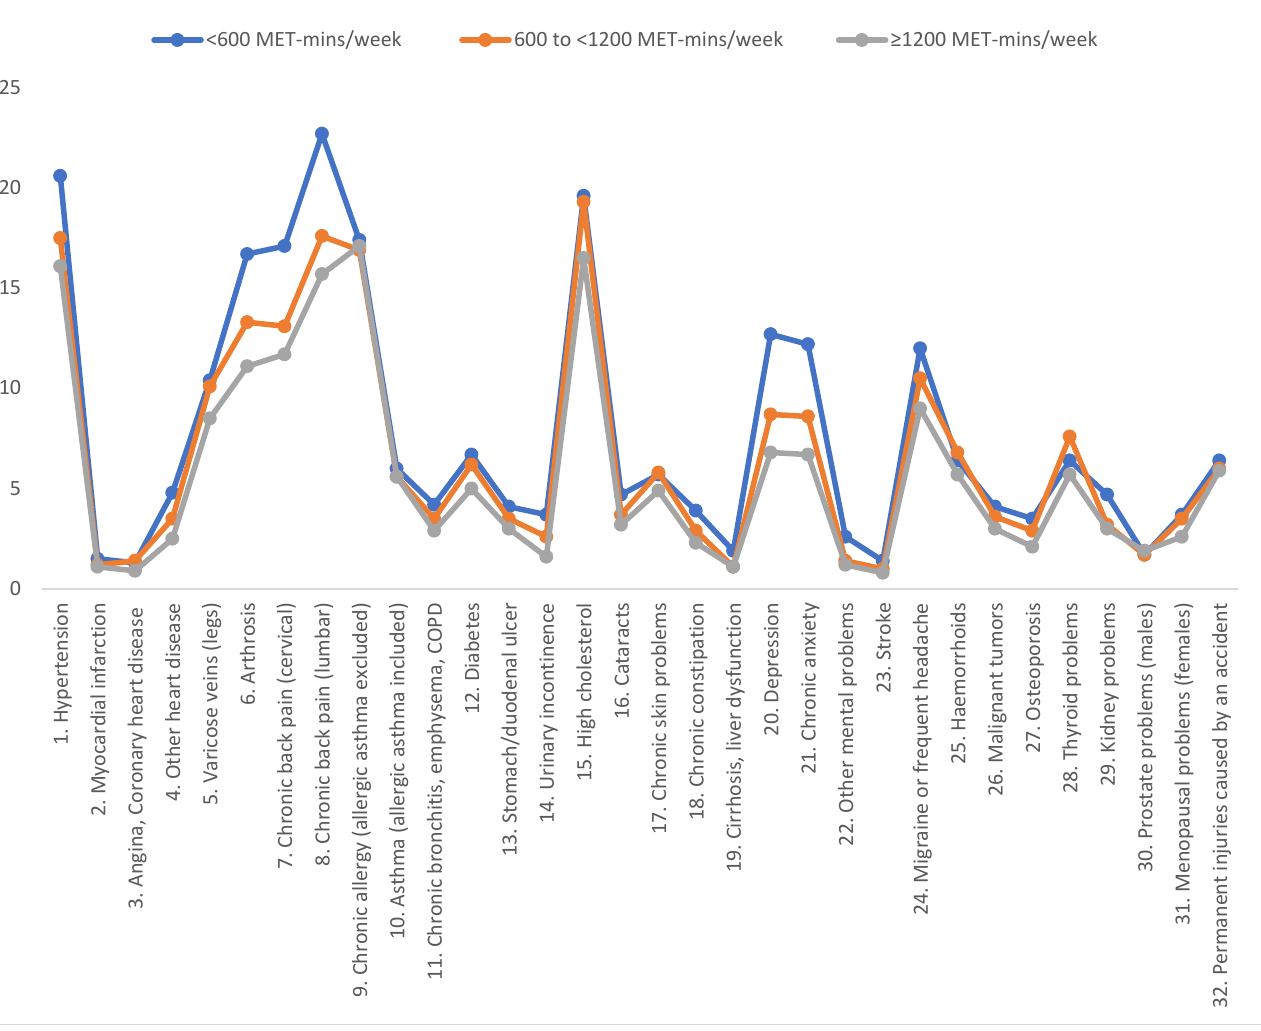
Figure 1. Prevalence of chronic conditions in Spanish adults by physical activity. Adjusted multivariable logistic regression analyses showed that less than 600 MET- Table 2. Association between low levels of physical activity (exposure) and chronic conditions min/week of physical activity was significantly associated with a higher risk of 19 chronic (outcome) in Spanish adults, estimated by multivariable logistic conditions: hypertension; other heart diseases; arthrosis; chronic back pain (cervical); chronic back pain (lumbar); stomach/duodenal ulcer; urinary incontinence; high choles- terol; cataracts; chronic constipation; cirrhosis, liver dysfunction; depression; chronic anx- iety; other mental problems; stroke; migraine or frequent headache; malignant tumours; osteoporosis; and kidney problems. All these significant associations, except for hyper- tension, were also maintained in those doing less than 1200 MET-min/week (Table 2).